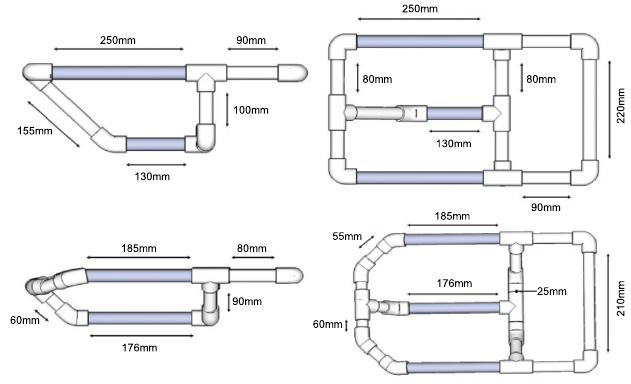
Figure 3. Examples of two possible chassis